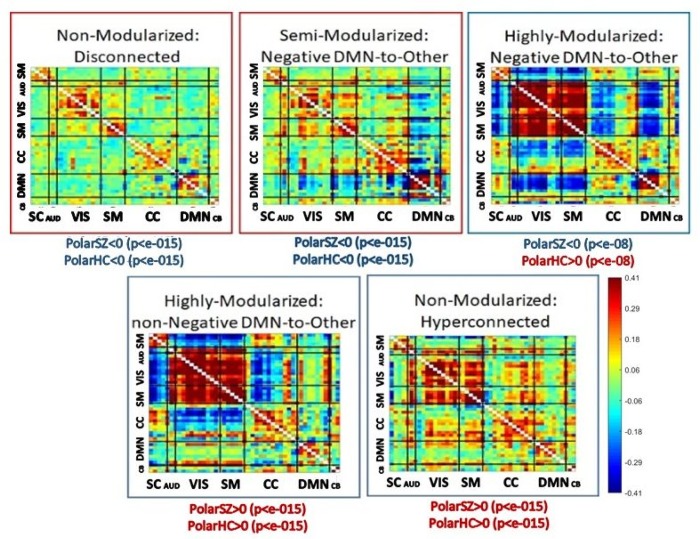
Labeled dFNC states with functional domains indicated along axes: Subcortical (SC), Auditory (AUD), Visual (VIS), Sensorimotor (SM), Cognitive Control (CC), Default Mode (DM), Cerebellar (CB); the dFNC states that are significantly more (resp. less) occupied by SZs are in red (resp. blue) boxes; significant elevation (red) or depression (blue) of brain polarity during windows characterized by each dFNC state are underneath each state. From left to right, and top to bottom, the occupancy rates of the dFNC states shown above are: Non-Modularized: Disconnected (0.26 HC, 0.47 SZ); Semi-Modularized: Negative DMN-to-Other (0.15 HC, 0.23 SZ); Highly-Modularized: Negative DMN-to-Other (0.16 HC, 0.09 SZ); Highly-Modularized: non-Negative DMN-to-Other (0.22 HC, 0.07 SZ); Non-Modularized: Hyperconnected (0.21 HC, 0.14 SZ).